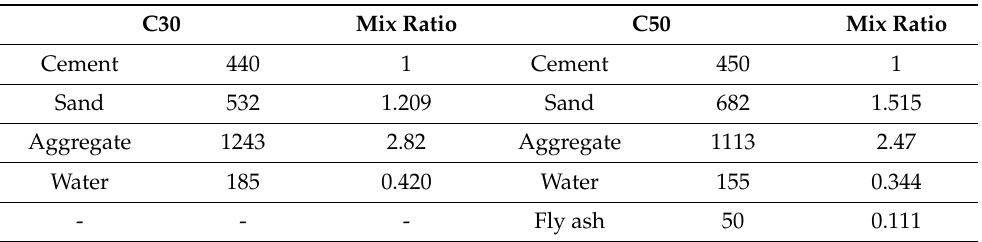
Table 1. Mix proportion of C30 and C50. Table 2. Material test results of concrete and steel